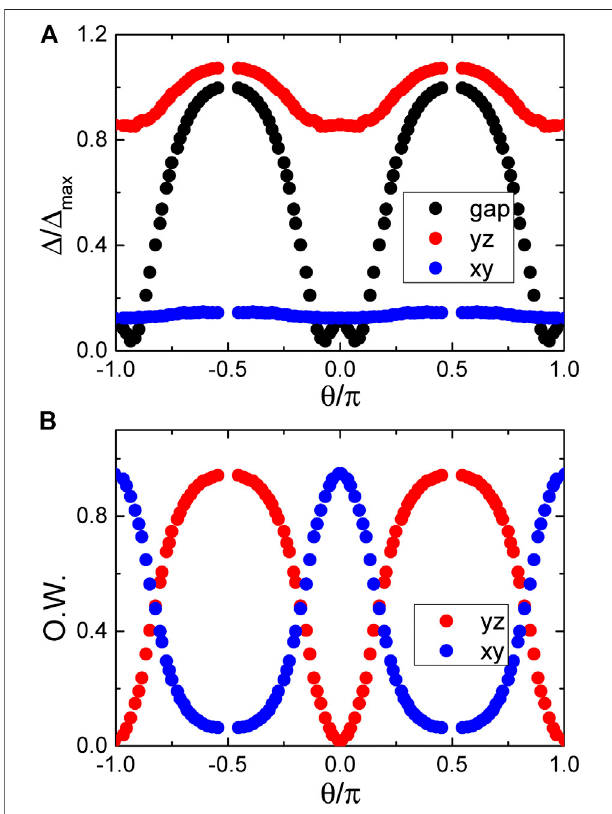
FIGURE 7 | (A) Overall (blue symbols) and orbital resolved superconducting gaps along the M x electron pocket. (B) Weight distributions of the d xy and d yz orbitals along the M x electron pocket, adapted from [144].